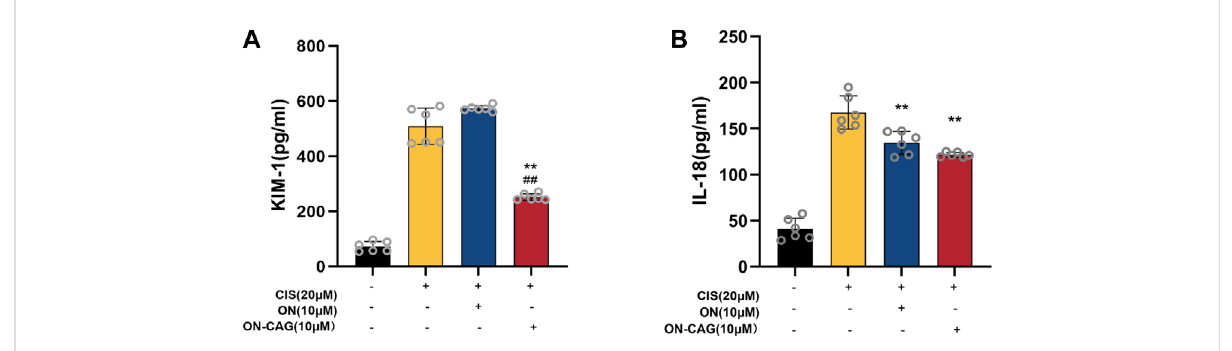
FIGURE 6 The effect of ON-CAG on cisplatin-induced KIM-1 (A) and IL-18 (B) expression in HK-2 cells. HK-2 cells were stimulated with 20 μ mol/L cisplatin for 24 h and then treated with 10 μ mol/L ON or ON-CAG for 24 h. Data were presented as the mean ± S.E.M. (A) , n = 3; (B) , n = 6. ** p < 0.01 compared with the cisplatin group. ## p < 0.01 compared with the ON